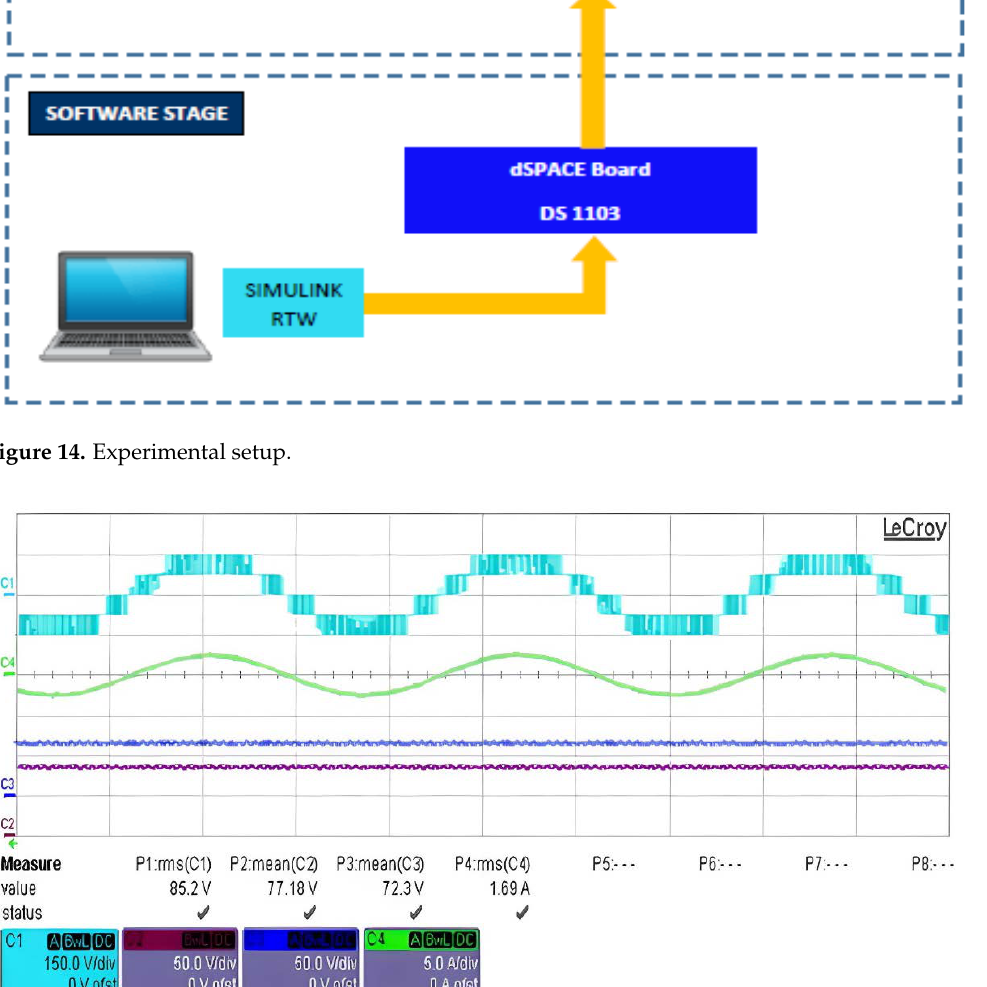
Figure 15. Experimental waveforms showing: output voltage of the inverter (C1), load current (C4) and capacitors voltages (C2 and C3).